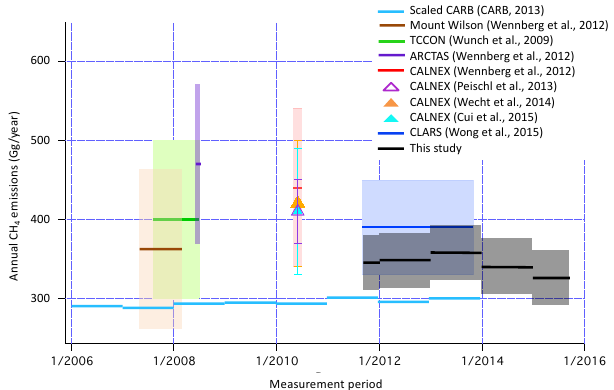
Figure 9. Comparison of annual CH 4 emission estimates (in unit of Gg per month) reported in the past 10 years. The Mount Wilson estimate reported by Wennberg et al. (2012) was derived for the South Coast Air Basin using the emission estimates based on Hsu et al.,